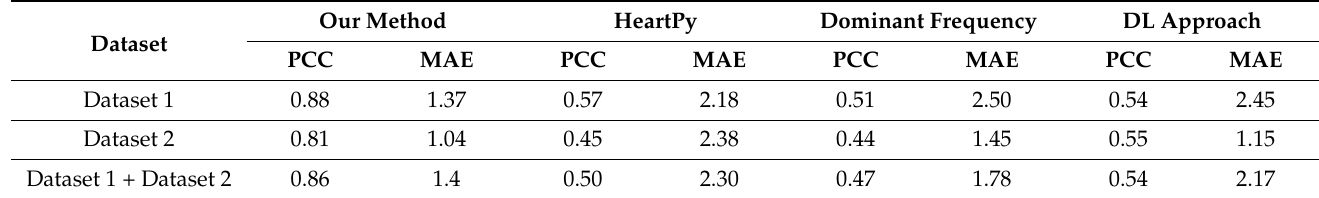
Table 1. Average mean absolute error (MAE), interpretable in breaths per minute, and Pearson’s correlation coefficient (PCC) achieved with the proposed ML-method and three baseline methods, using a window size of 20 s. The results are achieved using leave-one-subject-out (LOSO) cross- validation, on three dataset